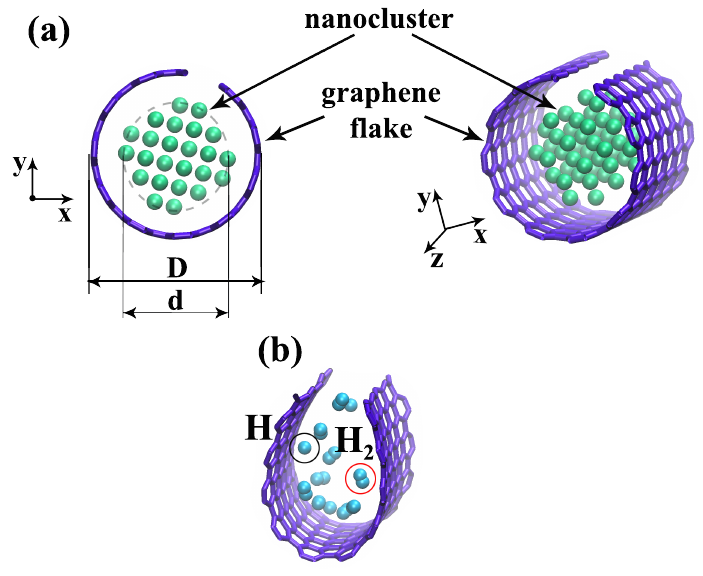
Figure 1. ( a ) Initial structure: graphene flake with the diameter D filled with nanocluster with the diameter d ; ( b ) atomic and molecular hydrogen inside the graphene flake.